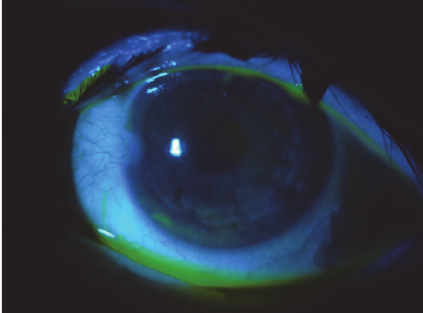
Figure 3: Corneal haze with linear subepithelial opacities in the anterior stroma.